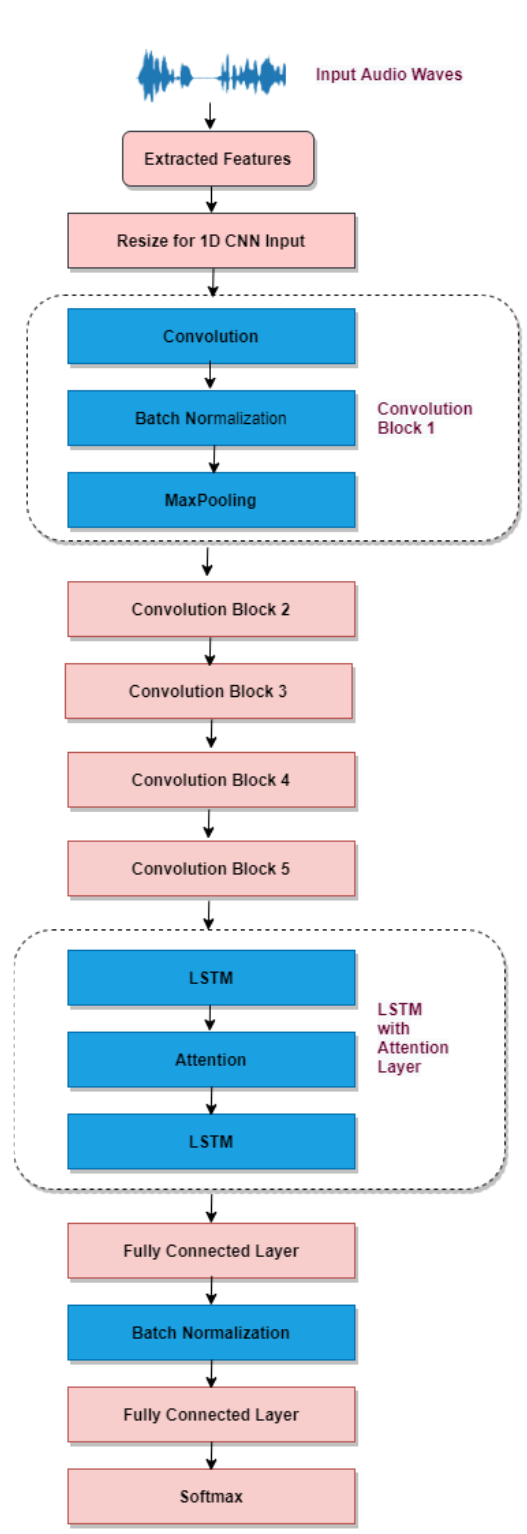
Figure 4. The 1D CNN with LSTM attention. In the second half, CNN’s output is sent into LSTM, determining the more profound temporal link between features. An additional attention layer was a way of acquiring additional information pertinent to each class. Lastly, the pooled feature map is remapped using two layers that are fully connected. Finally, the Softmax layer provided the likelihood of each class’s